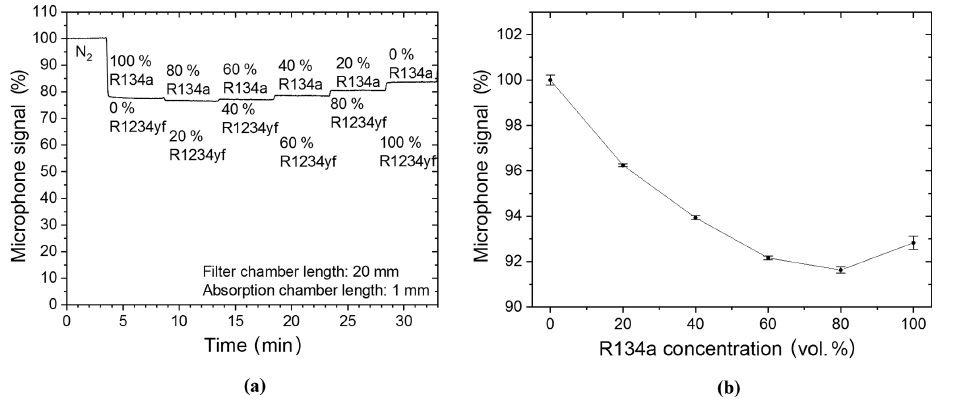
Figure 9. (a) Two-chamber-based R134a detector measurements of different mixture ratios (in vol.%) of R134a to R1234yf. (b) The resulting parabolic functional relation between the microphone signal and the R134a volume concentration when both refrigerants are mixed into the absorption chamber of the two-chamber-based detector. A simplified expression of the quadratic functional relation is f ( x ) = ax 2 + bx + c .